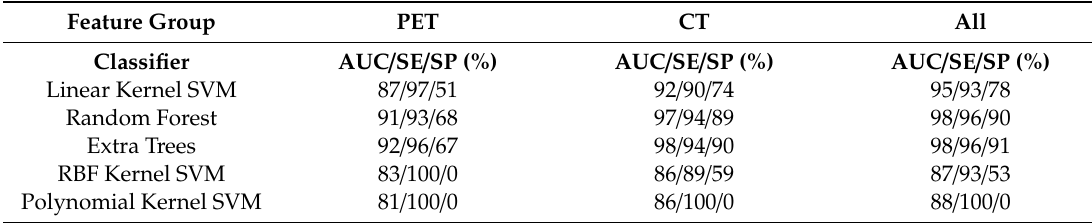
Table 3. Accuracy measures (area under the curve (AUC), sensitivity (SE), and specificity (SP)) obtained for ML classifiers applied to di ff erent feature groups with five-fold cross-validation. The CV cohort contained 48